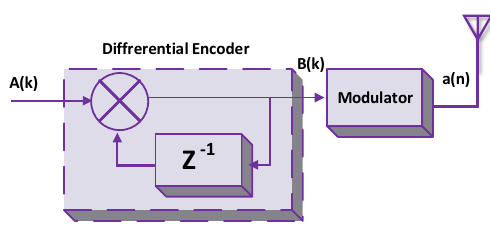
Figure 22. Differential encoder for a passive tag.